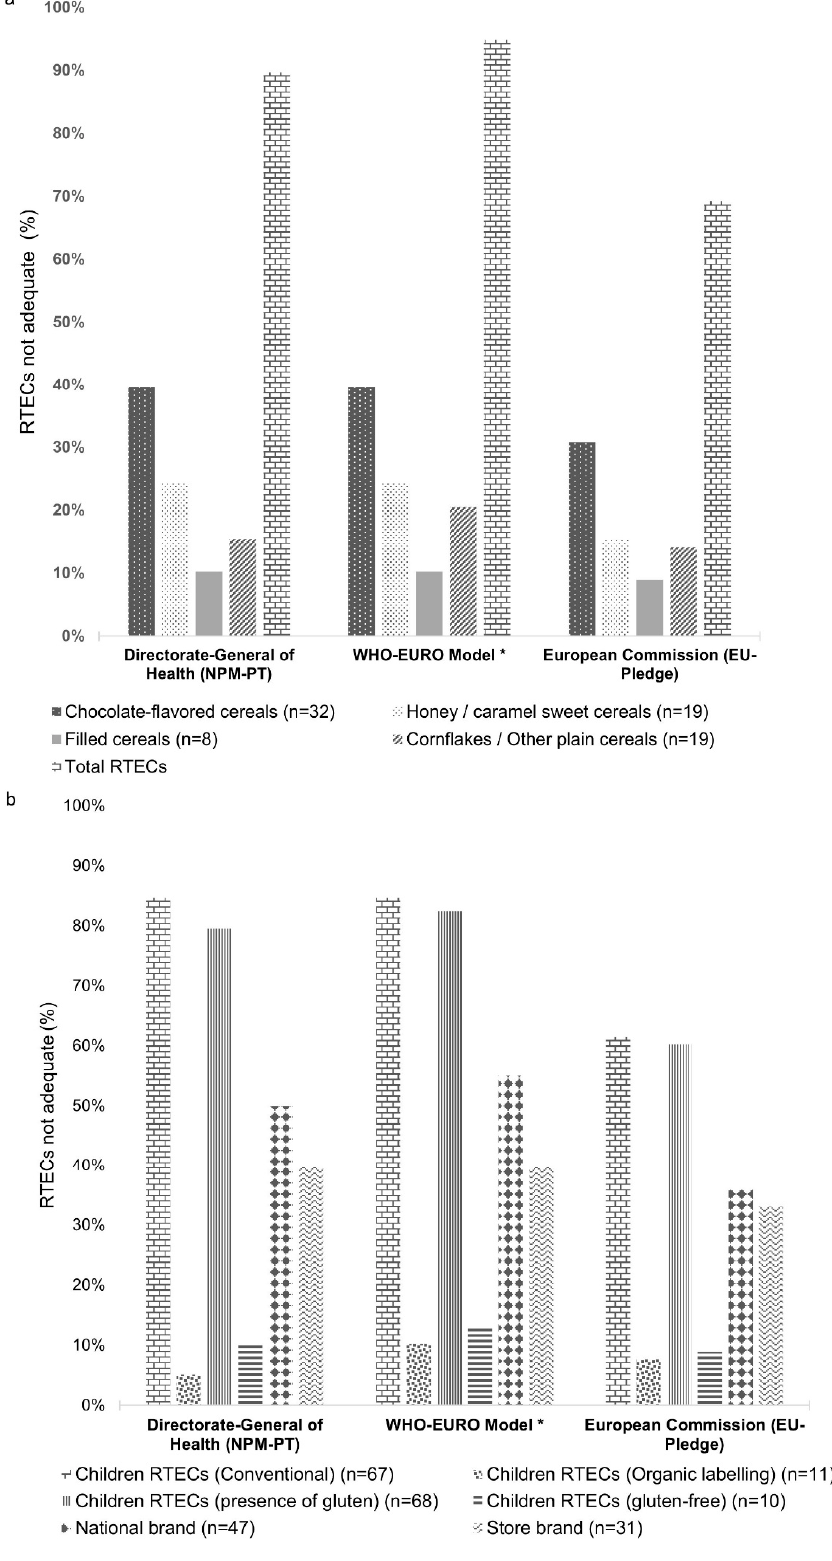
Figure 1. ( a ) Percentage of RTECs not adequate to be promoted by each nutrient profile model and ( b ) by nutrition claim (gluten), type of brand, and conventional/organic labelling. ( * ) For the WHO-EURO model application, the recommended minimum criterion fiber content of 6 g/100 g of product was included in evaluating the different RTECs. Across all RTECs, the WHO-EURO model classified 95% (74) of the 78 cereals ana- lyzed as non-adequate to be promoted for children. The corresponding figures for NPM- PT and EU-Pledge were 90% (70) and 69% (54), respectively, for all the products. The number of RTECs ( n = 78) that met the three nutrient profiles developed to regulate food marketing to children was low; only 5.1% ( n = 4) could be promoted to children according to the NPM-PT, WHO-EURO, and EU-Pledge models. The conventional RTECs ( n = 67) represent 86% of the cereals analyzed and the non- compliance rate was lower in the EU-Pledge model ( n = 48, 62%) when compared to the NPM-PT and WHO-EURO models ( n = 66, 85%). The organic ( n = 11) and gluten-free ( n = 10) labelling of children’s RTECs represent 14% and 13% of the cereals analyzed, respectively, and gluten-free cereals showed a higher non-compliance rate ( n = 8, 10%) compared with the organic RTECs ( n = 4, 5.1%) for the NPM-PT. The EU-Pledge revealed a non-compliance rate similar for both catego- ries of RTECs, 7.7% and 8.9%, respectively. The national RTECs brands ( n = 47) represent 60% of the cereals analyzed and did not comply with the criteria of the NPM-PT ( n = 39) and WHO-EURO ( n = 43) in 50% and 55% of brands, respectively. Figure 2 represents the compliance rate for the nutrient content of RTECs types with the criteria defined in the three nutrient profile models.